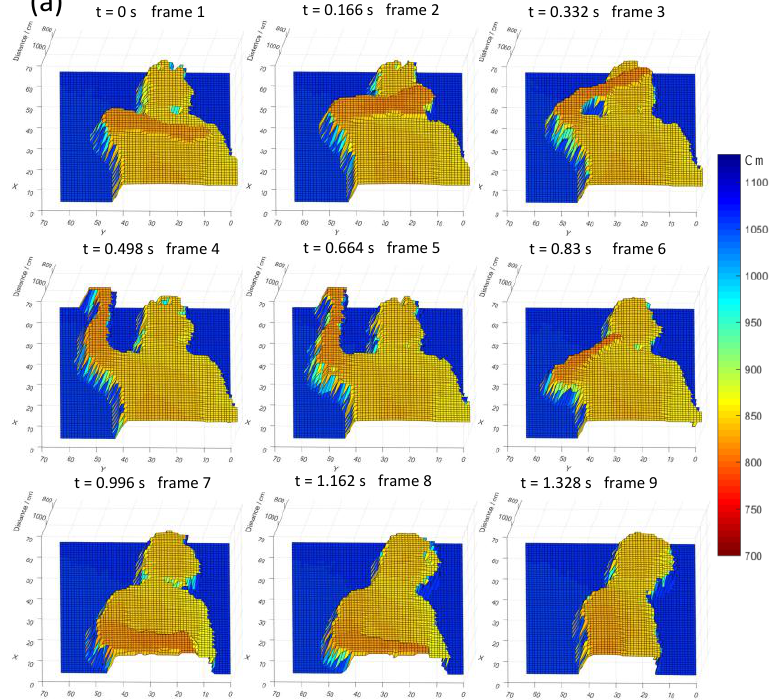
Table 2. Performance summary of the sensor and LiDAR system